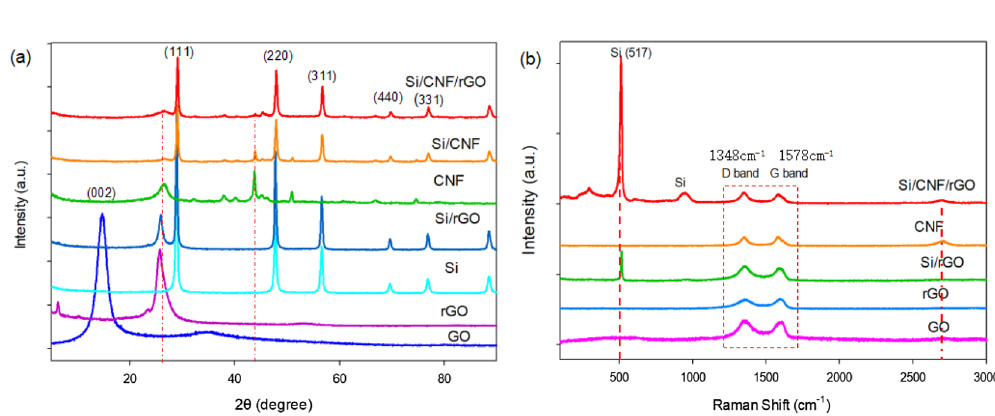
Figure 4. ( a ) X-ray diffraction patterns of Si/CNF/rGO, Si/CNFs, CNFs, Si/rGO, Si, rGO, and GO. ( b ) Raman spectra of the Si/CNF/rGO composite, CNFs, Si/rGO composite, rGO, and